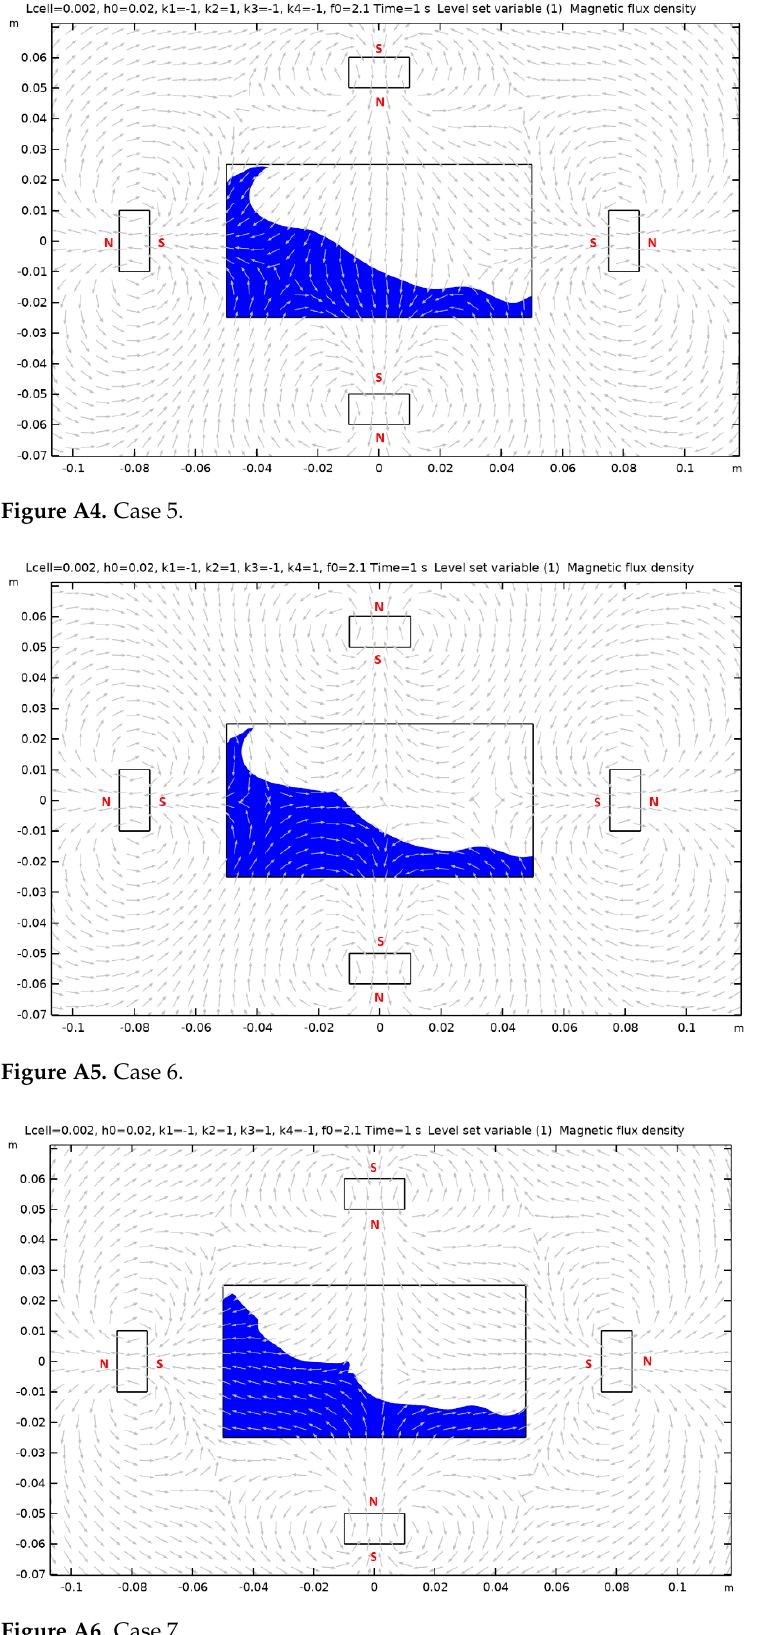
Figure A6. Case 7. Figure A6. Case 7.